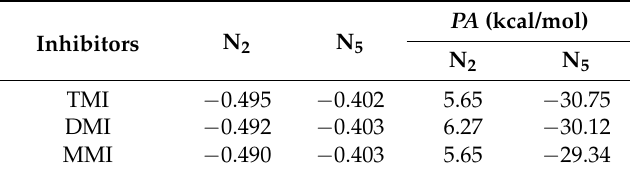
Table 5. Atomic charges on hetroatoms and proton affinity values. PA = proton